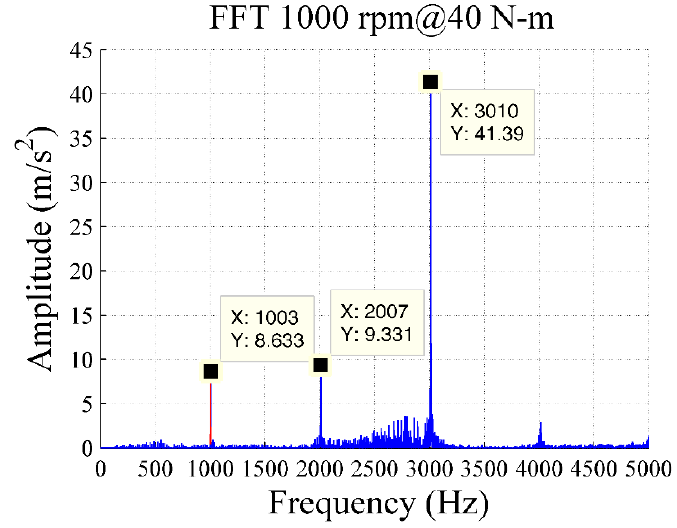
Figure 11. Spectrum of original acceleration in the frequency domain.